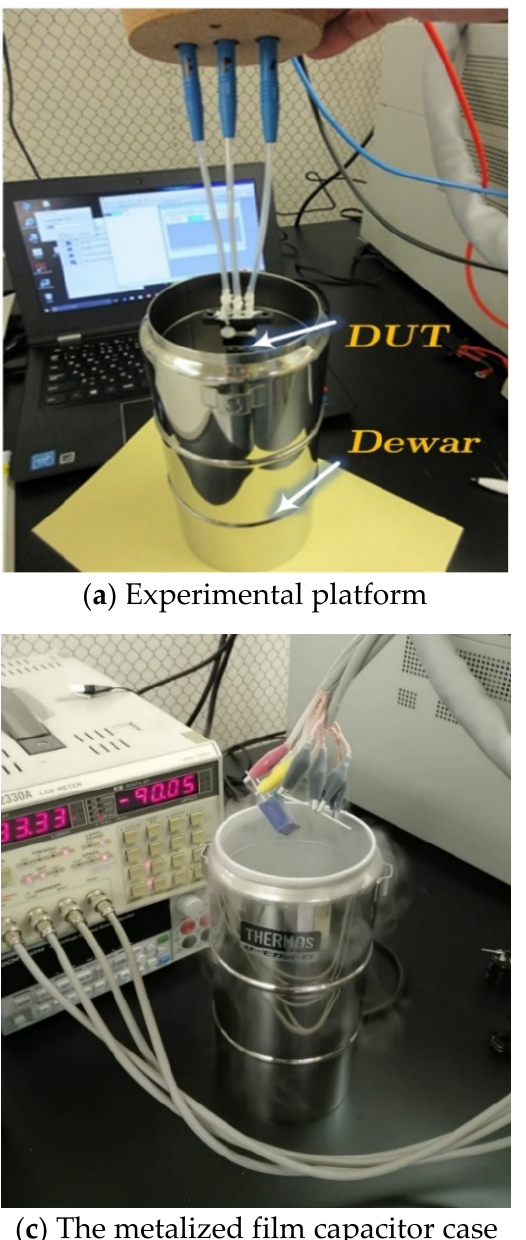
Figure 7. The experimental test setup.